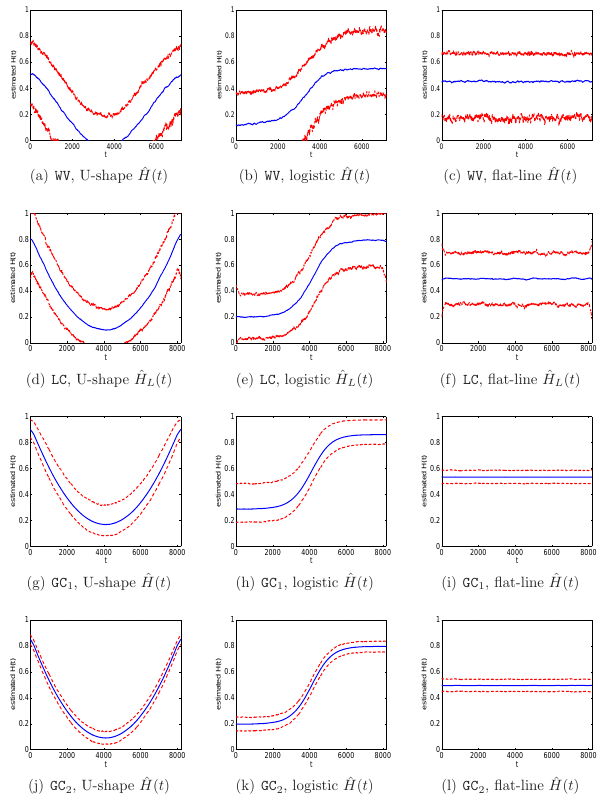
Figure 4: MSE averages for GC 1 depending on (a) different neighborhood sizes ν t and (b) filter dilation M are shown. Figure 2: Estimated H ( t ) (the middle line in blue) and their empirical 95% confi- Fig. 2. Estimated H(t) (the middle line in blue) and their empirical dence intervals (the upper and the lower dashed lines in red) for the three tested 95 % confidence intervals (the upper and the lower dashed lines in H ( t ) functions are shown. The upper row is for the WV method, the second row LC , the third row GC GC method using the average at ˆ C ), and the fourth row red) for the three tested H(t) functions are shown. The upper row 26 1 (the GC GC method using the median at ˆ C ). is for the WV method, the second row LC , the third row GC 1 (the GC 2 (the method using the average of ˆ C ), and the fourth row GC 2 (the GC method using the median of ˆ C ). 25